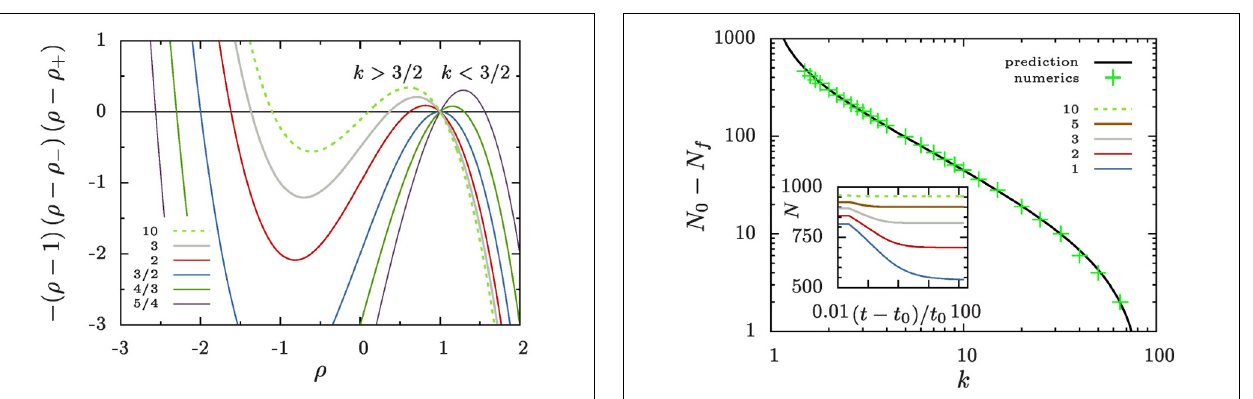
FIGURE 5 | The cubic polynomial in the numerator of Equation (16a). For all k > 1 its three roots give rise to three fixed points of the reduced radius, ρ , that are located at ρ = 1 and ρ = ρ ± . For k = 3 / 2 there is a bifurcation where the roots ρ = 1 and ρ + change stability.